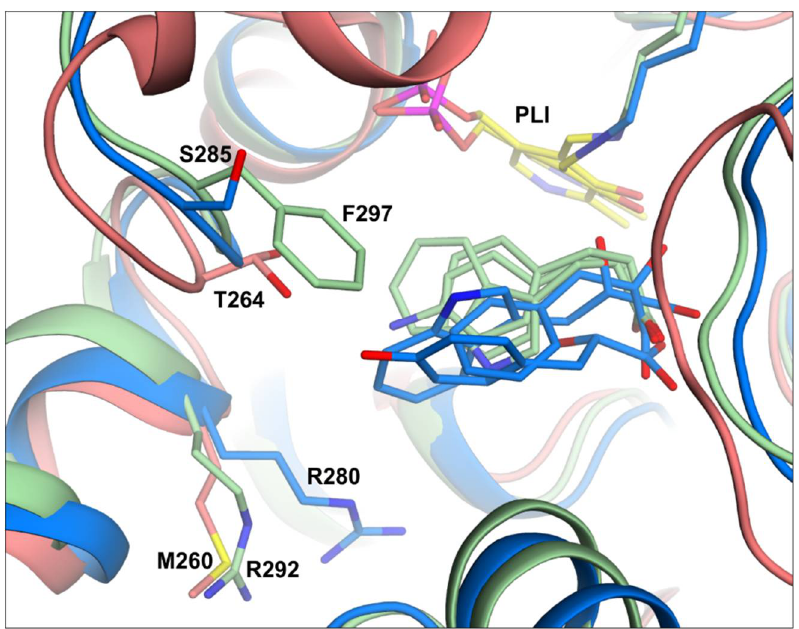
Figure 11. Structural comparison of the active center of bacterial aromatic aminotransferases with ligands: Psy ArAT (PDB ids: 6ZUR, 6ZUP, 6ZVG; blue), Pde ArAT (PDB ids: 2AY1, 2AY2, 2AY5; green) and Pho ArAT (PDB id: 1DJU; salmon). All ligands bound in the active center are shown in the